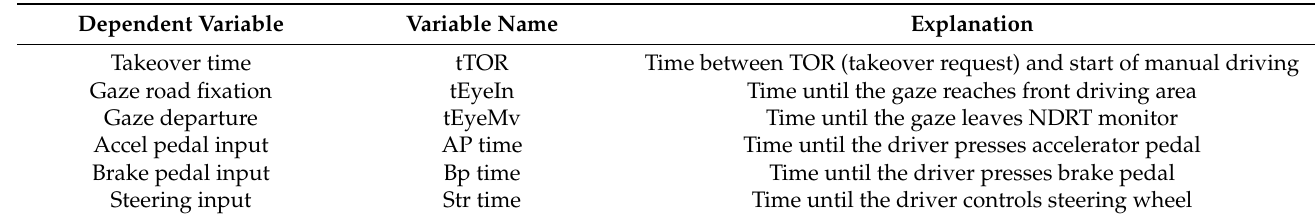
Table 1. Dependent variables measured in the study.